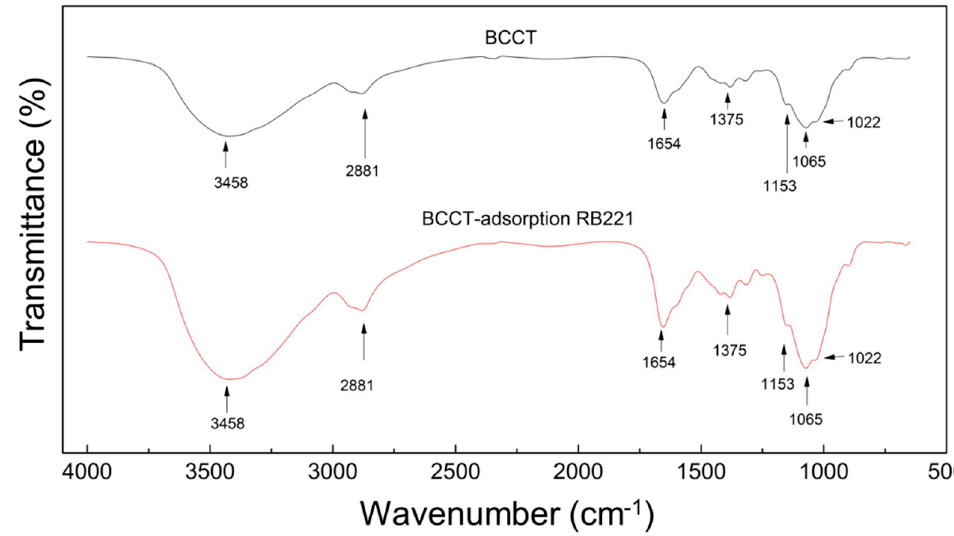
Figure 9. Changes in the FTIR spectra of BCCT before and after the adsorption of the RB221 dye.